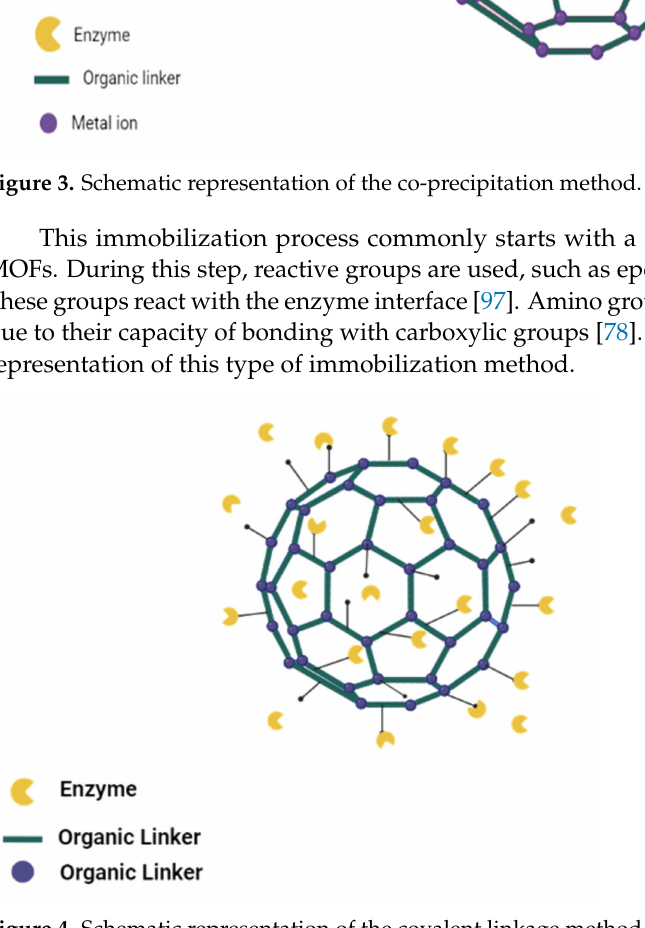
Figure 4. Schematic representation of the covalent linkage